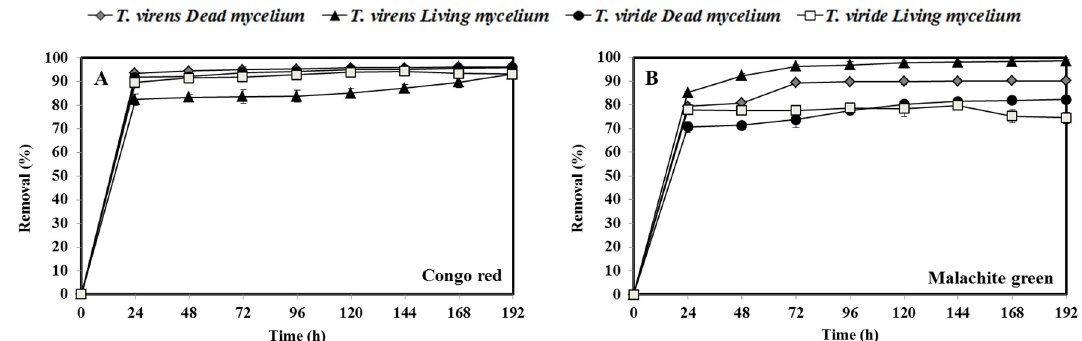
Figure 2. ( A ) Removal of Congo red (50 mg L − 1 ) and ( B ) malachite green (50 mg L − 1 ) by fungal fresh biomass (living or dead), for eight days.